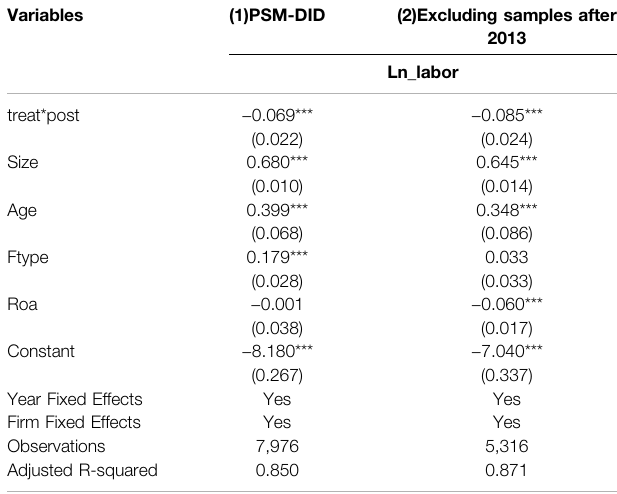
TABLE 3 | The results of the instrumental variable. Variables